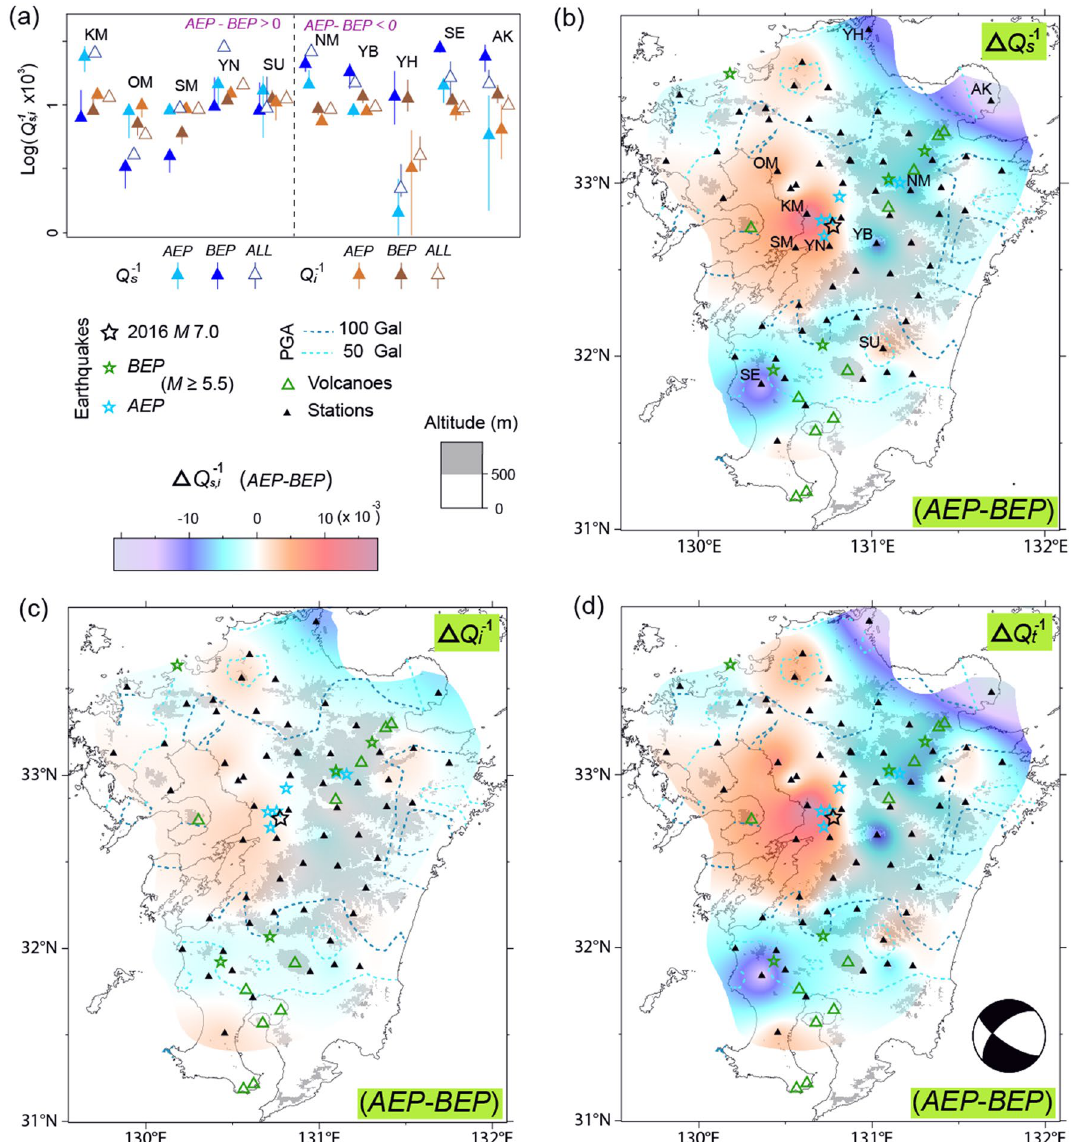
Figure 5. ( a ) The Q s –1 and Q i –1 value of the BEP (blue and brown, respectively) and AEP (violet and orange, respectively) are compared for the stations. All ( BEP + AEP ) of Q s –1 and Q i –1 value is also plotted as blue and brown open triangles, respectively. The common logarithm of Q s –1 value multiplied by 10 3 , AEP-BEP , are divided by dotted line as 5 largest (plus) and 5 smallest (minus) ones. The error bars are based on Fisher’s F distribution with a confidence of 60%. ( b – d ) Topographic maps showing the difference between the BEP and AEP ( AEP-BEP ) for the Q s –1 , Q i –1 , and Q t –1 value, respectively, of the Kumamoto earthquake at 1.5 Hz. Focal mechanism of mainshock in ( d ) is from CMT catalog from Hi-net (https:// www. hinet. bosai. go. jp/ AQUA/ aqua_ catal ogue. php? LANG= en). The other symbols are the same as those in Fig. and BEP-AEP , while, including all ( AEP + BEP ) data. Values of Q s –1 and Q i –1 for all stations except YN and of Q s –1 for all stations except NM are located between AEP and BEP with shorter error bars. The five largest increase of Q s –1 , ranging from 0.004 to 0.016, were mainly distributed in the basin area with elevations below 500 m, and close to the epicenter of K (Fig. 5b). However, for the basin area in the eastern coast of event K region showing high PGA, stations could not be analyzed because data of very few events were available (≤ 10). The corresponding increase of Q i –1 was observed in the basin area with values up to 0.003. For the extensive region surrounding the basin area, even higher decreases of Q s –1 and Q i –1 compared to the increases in Q s –1 and Q i –1 were observed, ranging from 0.007 to 0.019 and 0.002 and 0.008, respectively. However, several high values (i.e., those at stations AK and YH) showed large error bars due to the small number of observation data. For event T , notable variations of Q s –1 and Q i –1 value did not appear to be related to the location of the epicenter (see Supplementary Fig. S5). However, event G showed variation associated with the epicenter, with similarly large values of Q s –1 and Q i –1 , ranging from − 0.002 to 0.008, and from − 0.003 to 0.007, respectively (Fig. 6a). Values